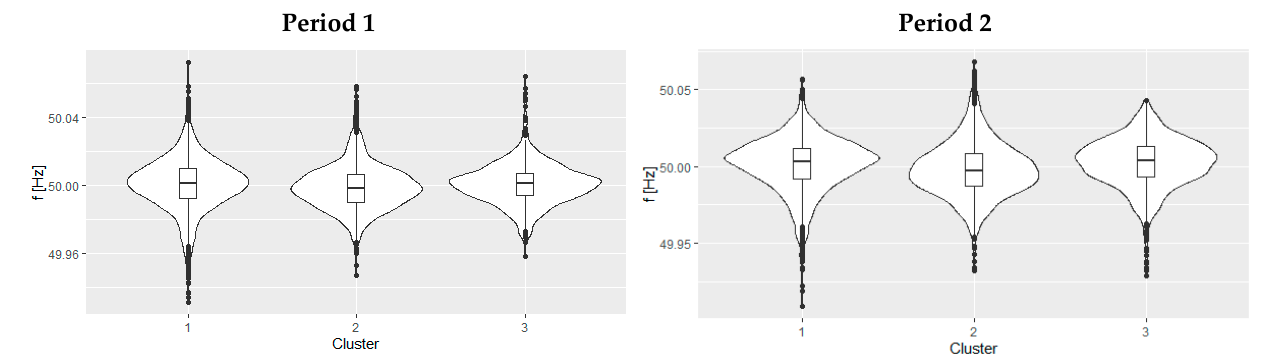
Figure 7. Violin plots of frequency comparing clusters for Period 1 and Period 2.